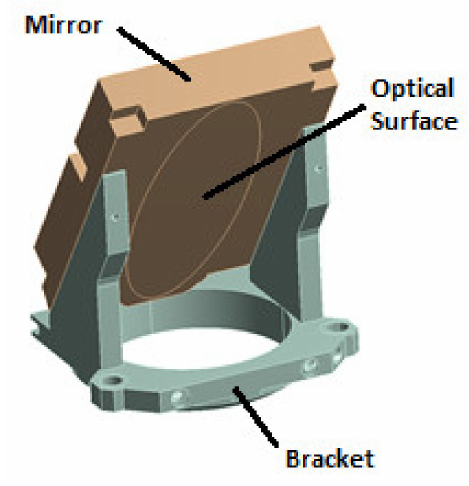
Figure 5. Mirror and its bracket geometry.